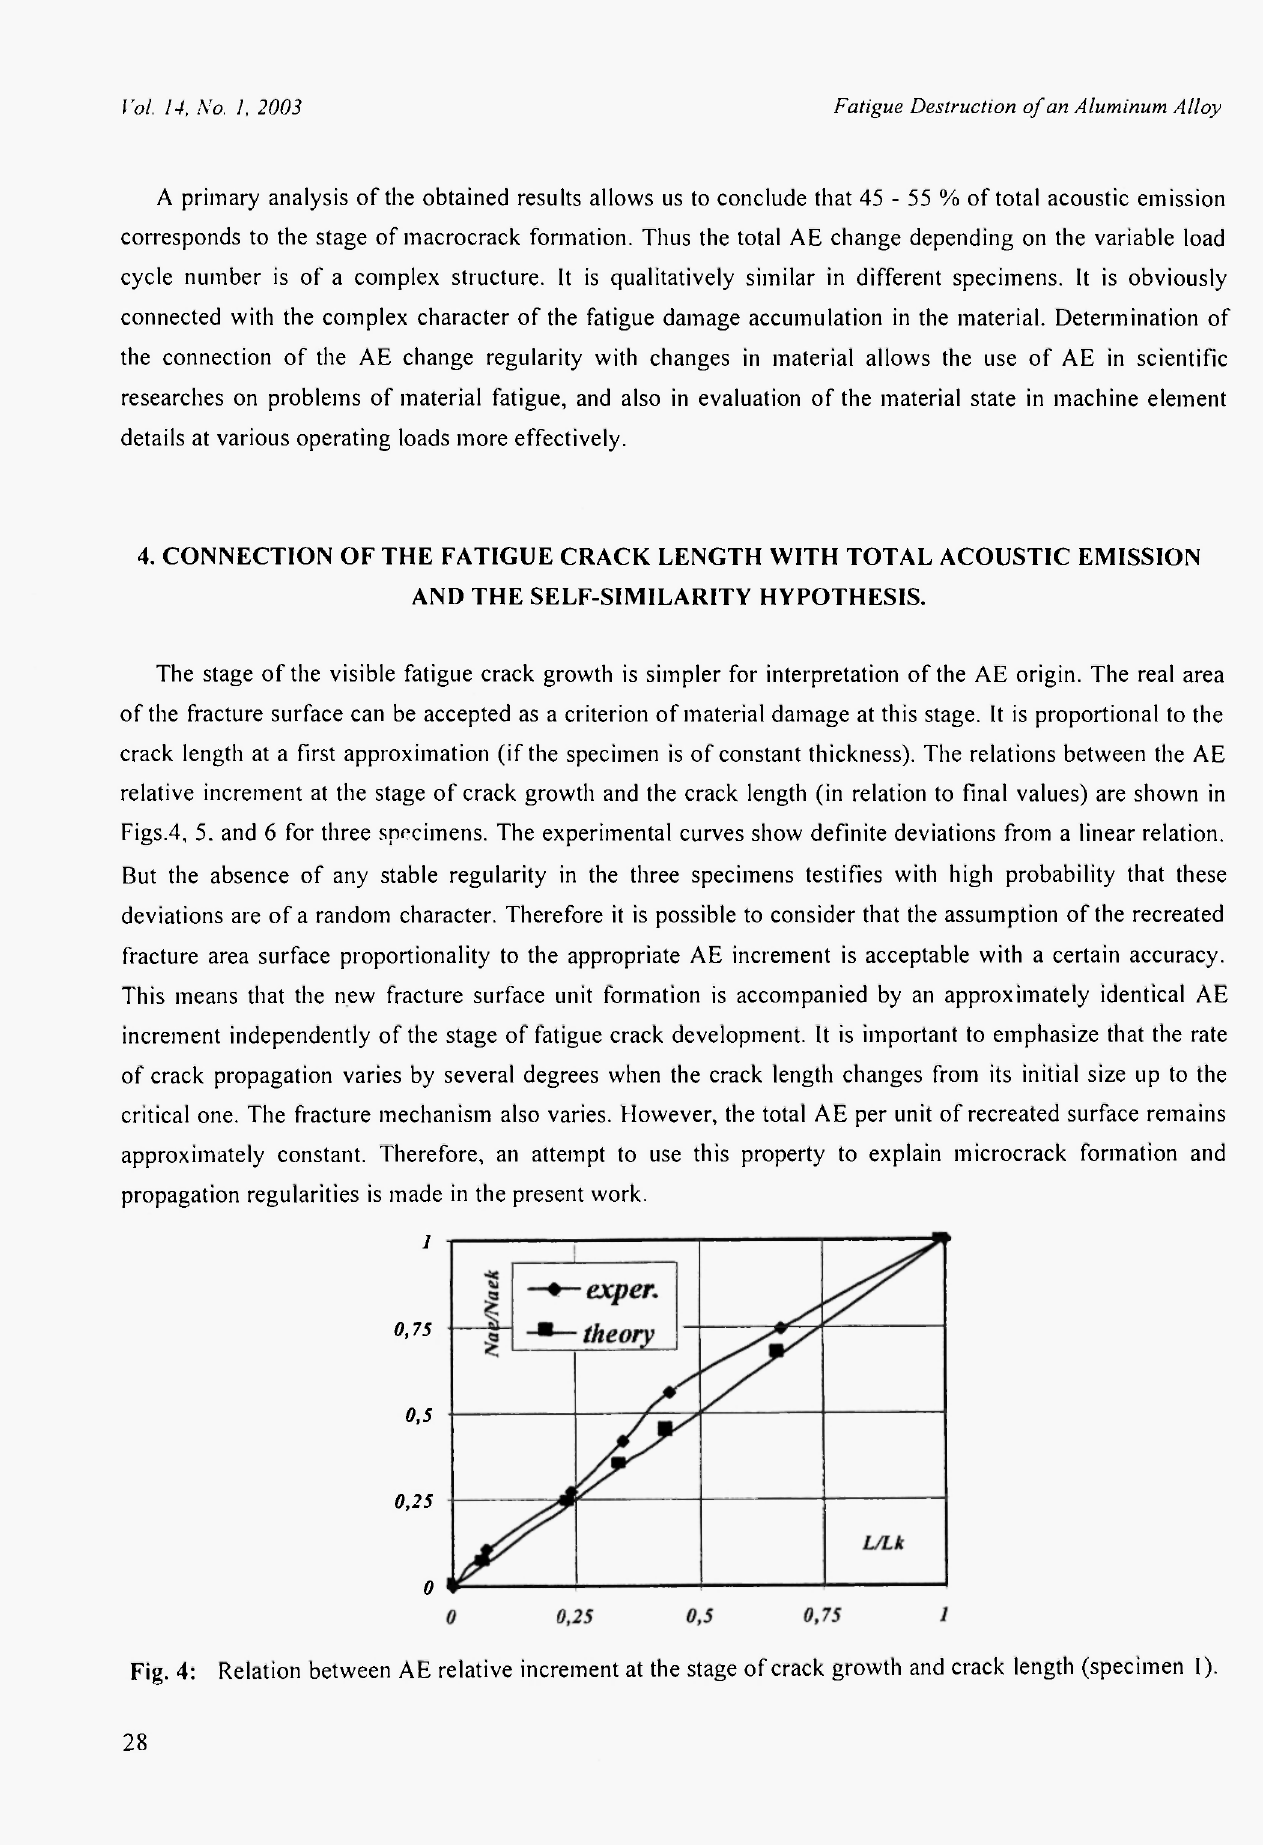
Fig. 4: Relation between AE relative increment at the stage of crack growth and crack length (specimen I ).